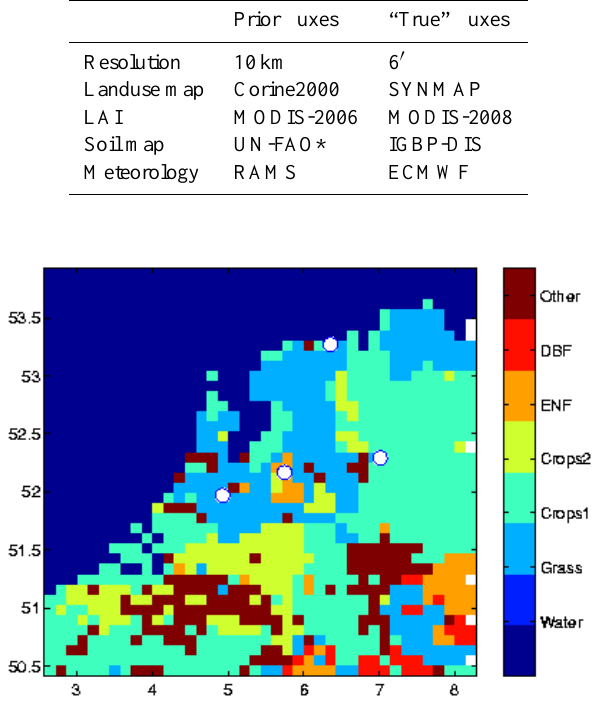
Fig. 1. The domain of the study showing the distribution of six different land-use categories according to the Corinne database, as well as 4 locations where continuous, calibrated measurements of CO 2 are available (Cabauw, west; Lutjewad, north; Loobos, middle; Hengelman; east). The area displayed, shown as lat long on the x and y axis is used in the RAMS meso-scale transport model, and is resolved on 10 × 10km spatial